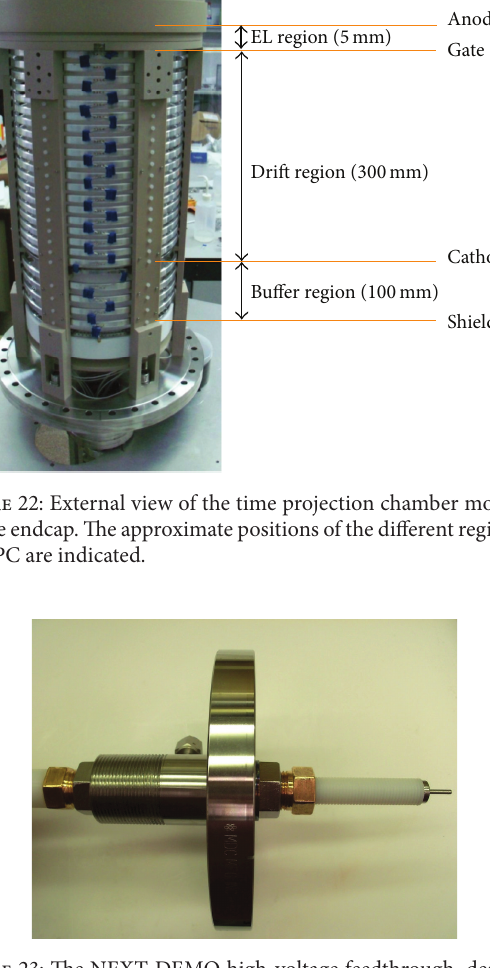
Figure 23: The NEXT-DEMO high-voltage feedthrough, designed and built by Texas